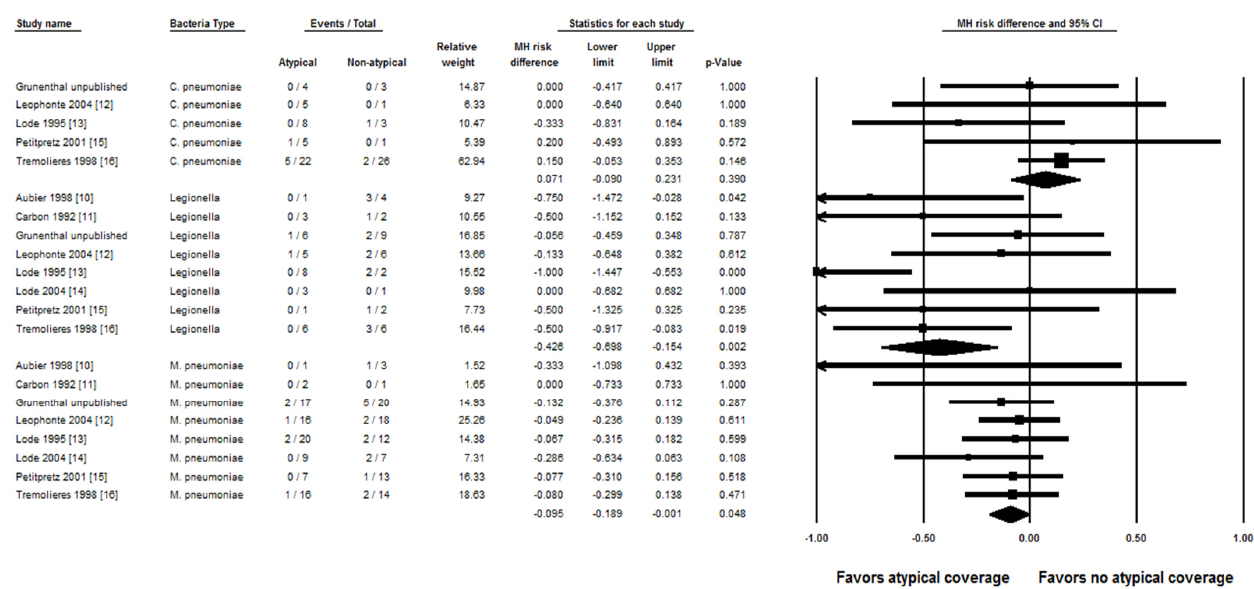
The rate of clinical failure was significantly lower with empiric atypical coverage in patients with Legionella spp. (RD, − 42.6%; 95% CI, − 69.8% to − 15.4%; p -value = 0.002; (Figure 2). There was no significant difference in rate of clinical failure in patients with